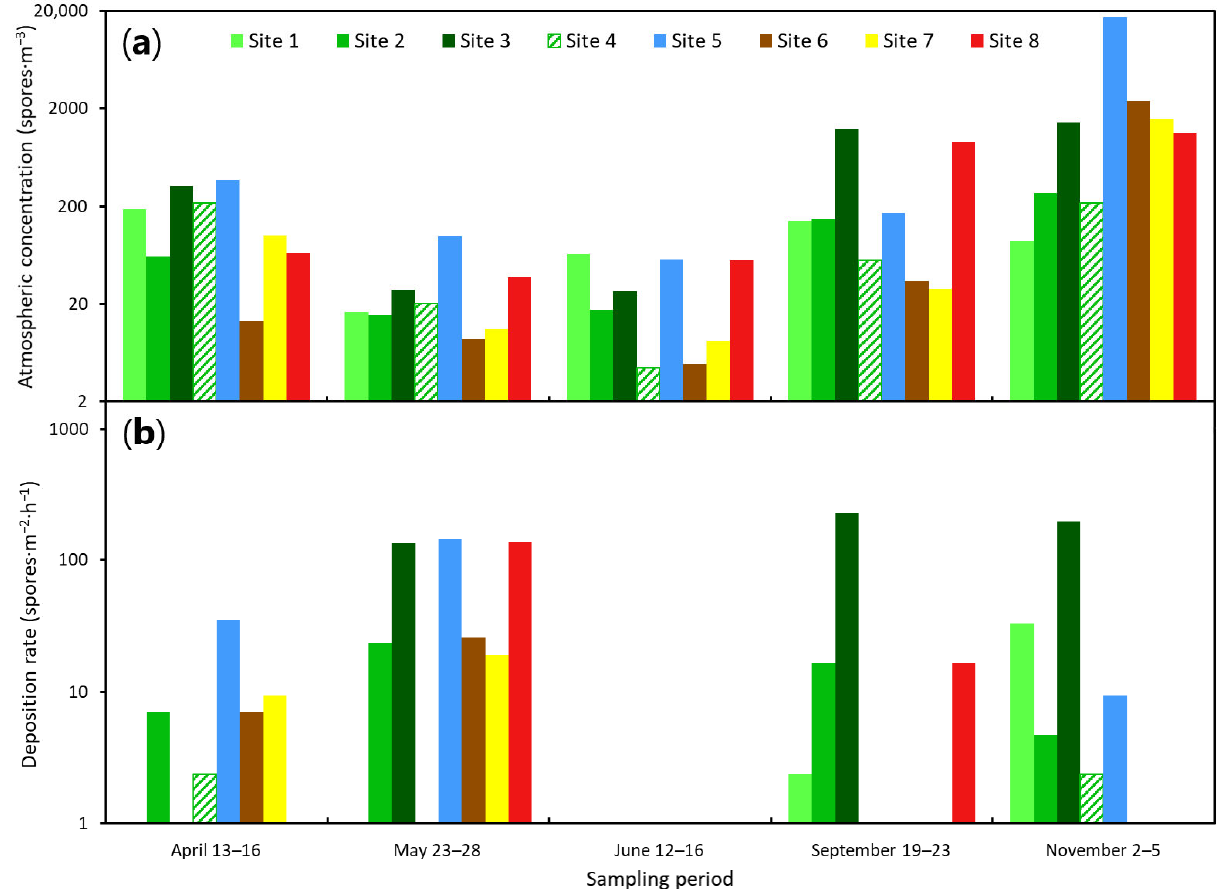
Figure 1. Temporal variation in spore dispersal of H. annosum s.l. in eight forest stands, determined by the simultaneous use of ( a ) automatic volumetric spore trap and ( b ) wood disc exposure method. Seasonal differences were revealed in H. annosum s.l. spore dispersal (Figure 1). DR was significantly higher in May (median = 25 spores ∙ m − 2 ∙ h − 1 ) than in June, when no spores were trapped ( z = 3.293, p = 0.0050; Supplementary Data, Table S2). c Ha was significantly higher in November (median = 1290 spores ∙ m − 3 ) than in May (18 spores ∙ m − 3 , z = 4.085, p = 0.0002) and June (22 spores ∙ m − 3 , z = 3.978, p = 0.0003; Supplementary Data, Table S1). The majority of spores caught by WDE in May belong to H. parviporum , while H. abietinum was predominant in November. The composition of AVST samples varied to a